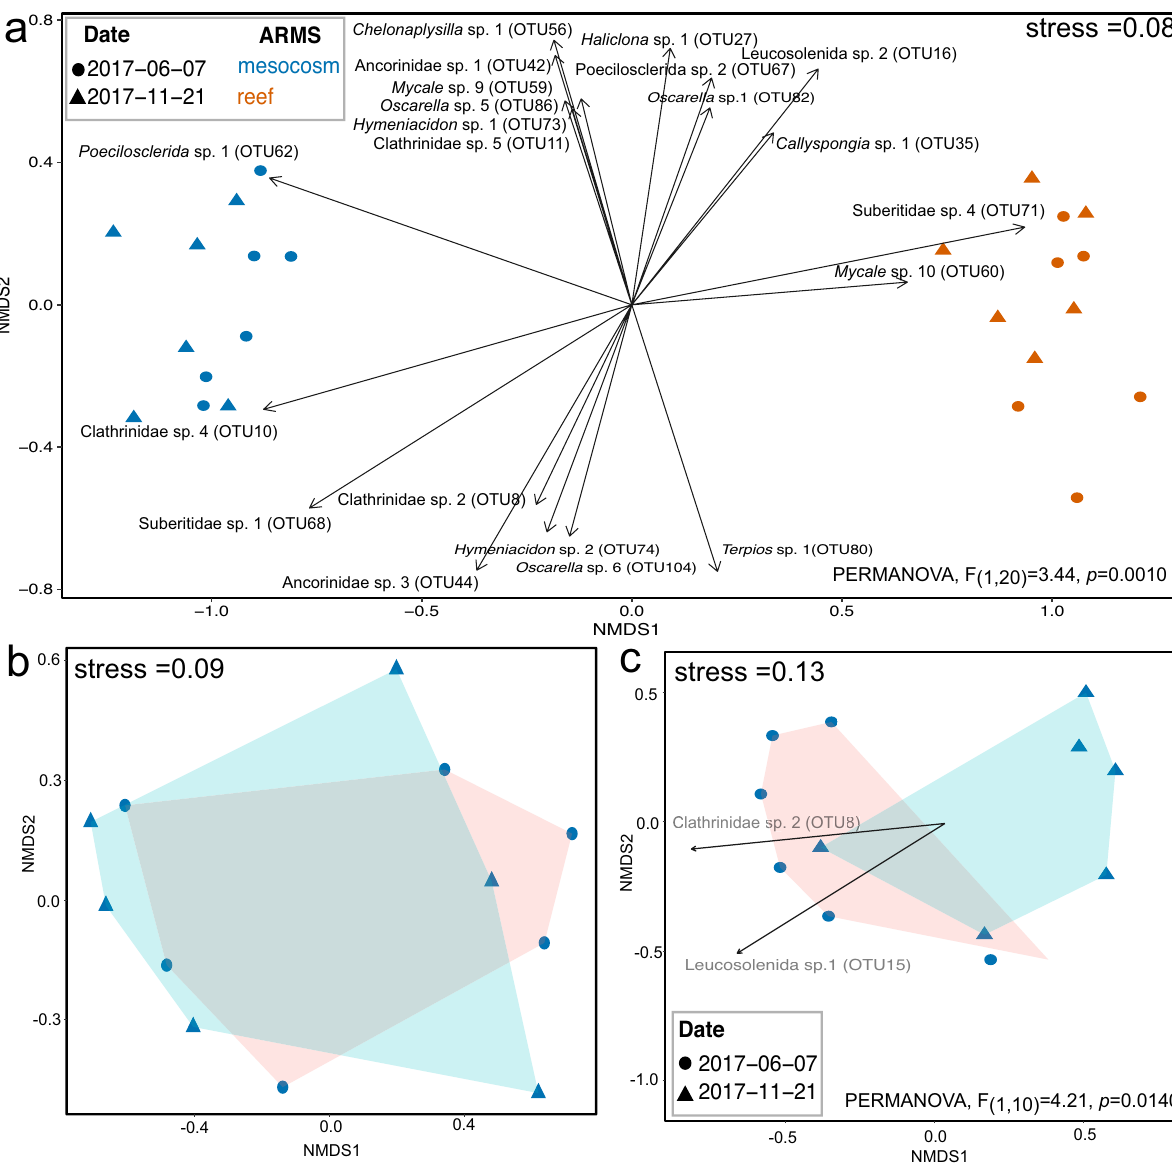
Figure 3. Community composition using multidimensional scaling of Bray–Curtis distances of ( a ) all sponges in mesocosm (in blue) and reef ARMS (in orange) at time points showing peak recruitment at 11 months (June 2017 as triangles) and minimum recruitment at 16 months (November 2017 as circles) thereafter. Community composition of dominant sponge classes ( b ) Demospongiae and ( c ) Calcarea from mesocosm conditions were also analyzed separately. Community composition for the two time points is outlined by blue and pink convex hulls. Significant PERMANOVA results are reported for significant differences in habitat types ( a ) and within the sponge class Calcarea ( c ) in mesocosm ARMS. Vectors in ( a ), and ( b ), show OTUs responsible for significant temporal shifts ( p = 0.01) within the sponge community